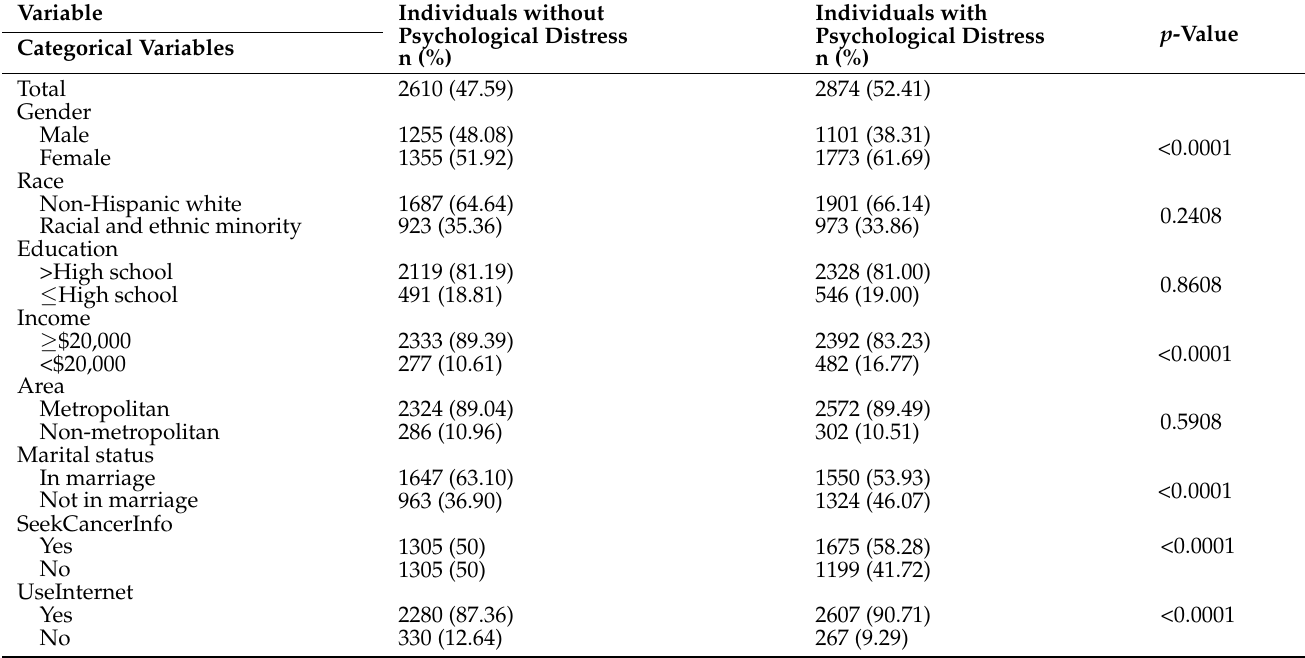
Table 1. Distribution of the characteristics of the 26 extracted variables in the HINTS